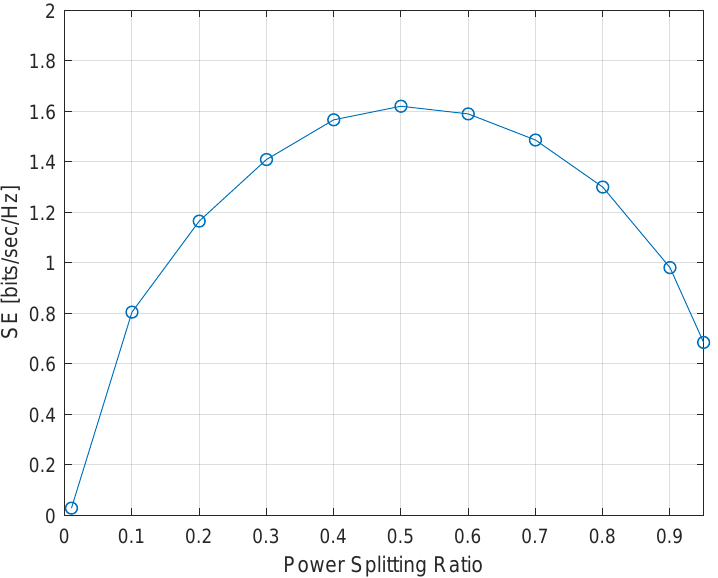
Figure 3. Spectral Efficiency (SE) at 20 dB versus the power splitting